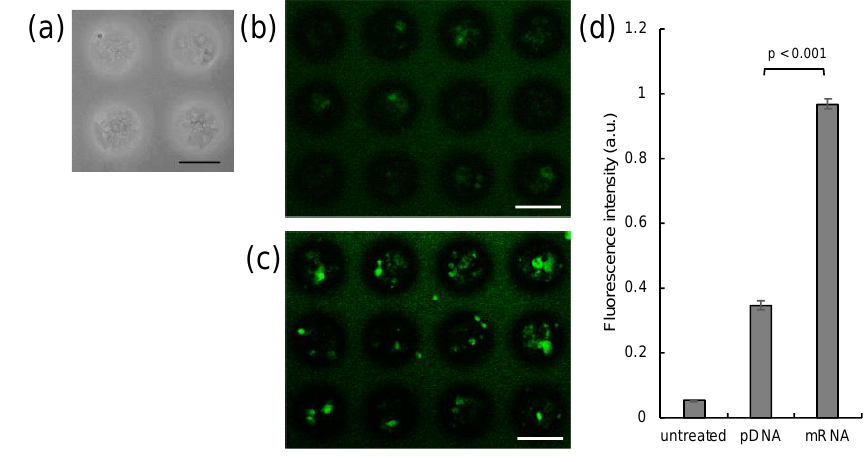
Figure 1. Introduction of GFP pDNA and mRNA to MSC spheroids. ( a ) MSC spheroids were prepared 3 days after seeding MSCs onto a micropatterned plate. ( b–d ) GFP expression in spheroids 24 h after